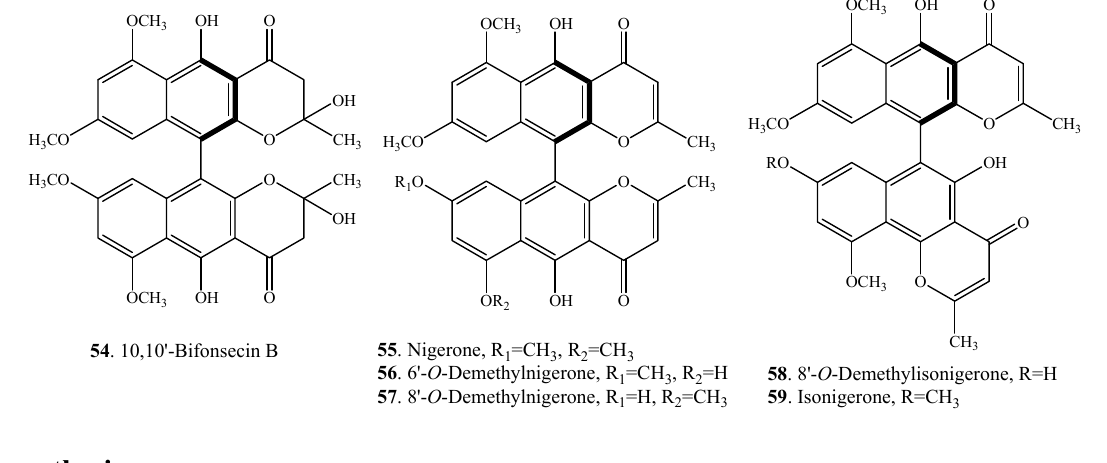
Figure 3. Structures of nigerone-type bis-naphtho- γ -pyrones ( 54 – 59 ) from fungi.